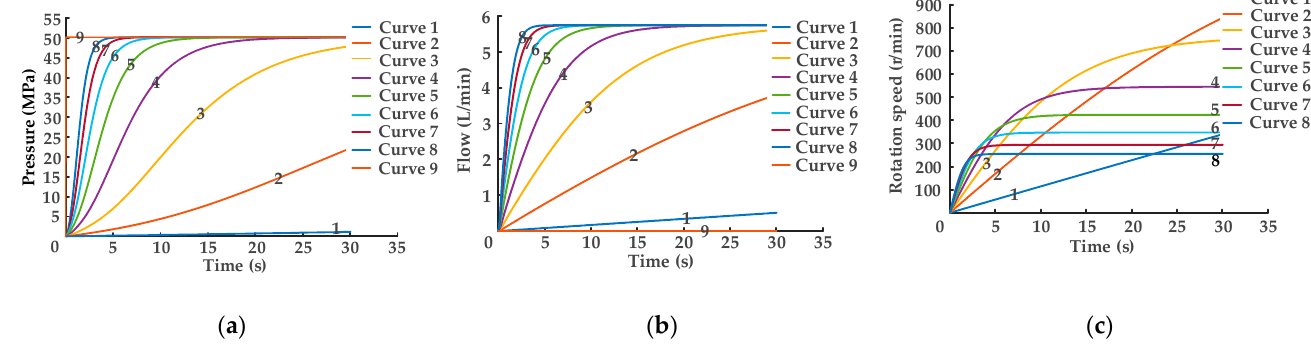
Figure 5. Regulation characteristic curves of DHT in the holding pressure stage: ( a ) pressure regulation; ( b ) flow regulation; ( c ) gear–pump/motor units’ rotational speed characteristic curves. Curves 1–8 in Figure 5a,b represent the regulation characteristic curves of pressure and flow with time at oil port A, curve 9 in Figure 5a illustrates the adjustment characteristic curve of oil port P pressure with time, and curve 9 in Figure 5b provides the modification characteristic curve of the flow of tank oil into oil port T with time. The binary digit of the control valve groups corresponding to curve 1 is N i 1 = 1000, N o 1 = 1000. The binary logic combination of the eight solenoid directional valves corresponding to curve 8 is N i 15 = 1111, N o 15 = 1111. In accordance with the control matrix (6), curves 1–8 are the increasing displacement control of DHT; that is, the binary digit logic combination is set